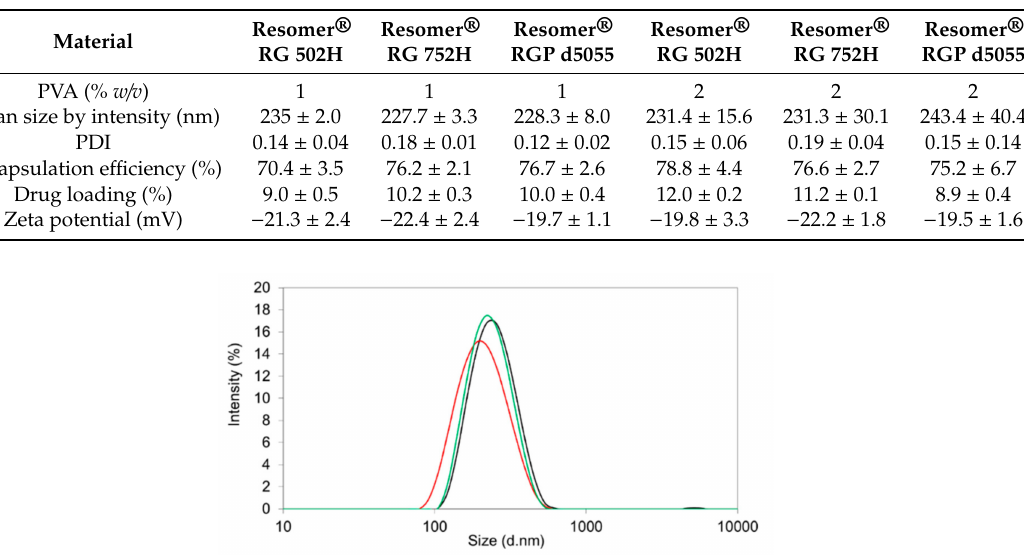
Table 1. Properties of Resomer–sorafenib nanoparticles as a function of the encapsulating polymer and emulsifier (PVA) concentration.